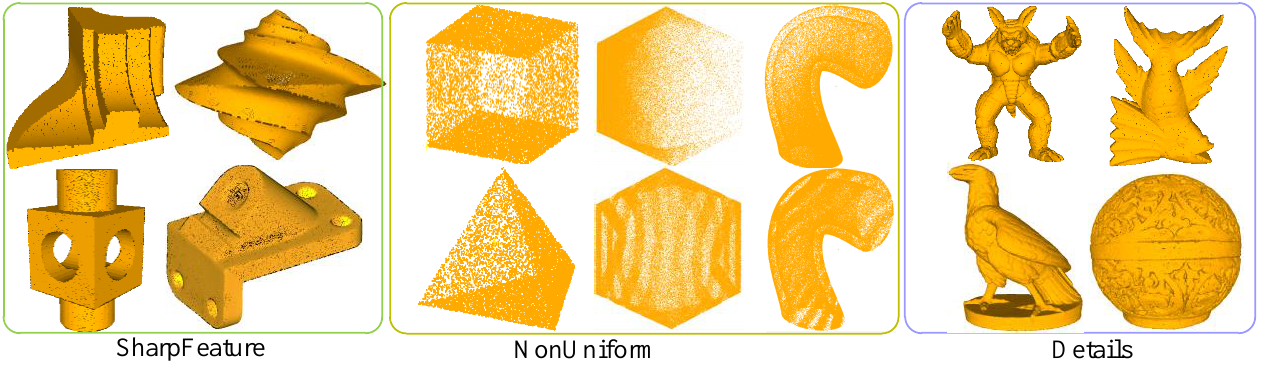
Figure 5. The point cloud models used to test the experiment.